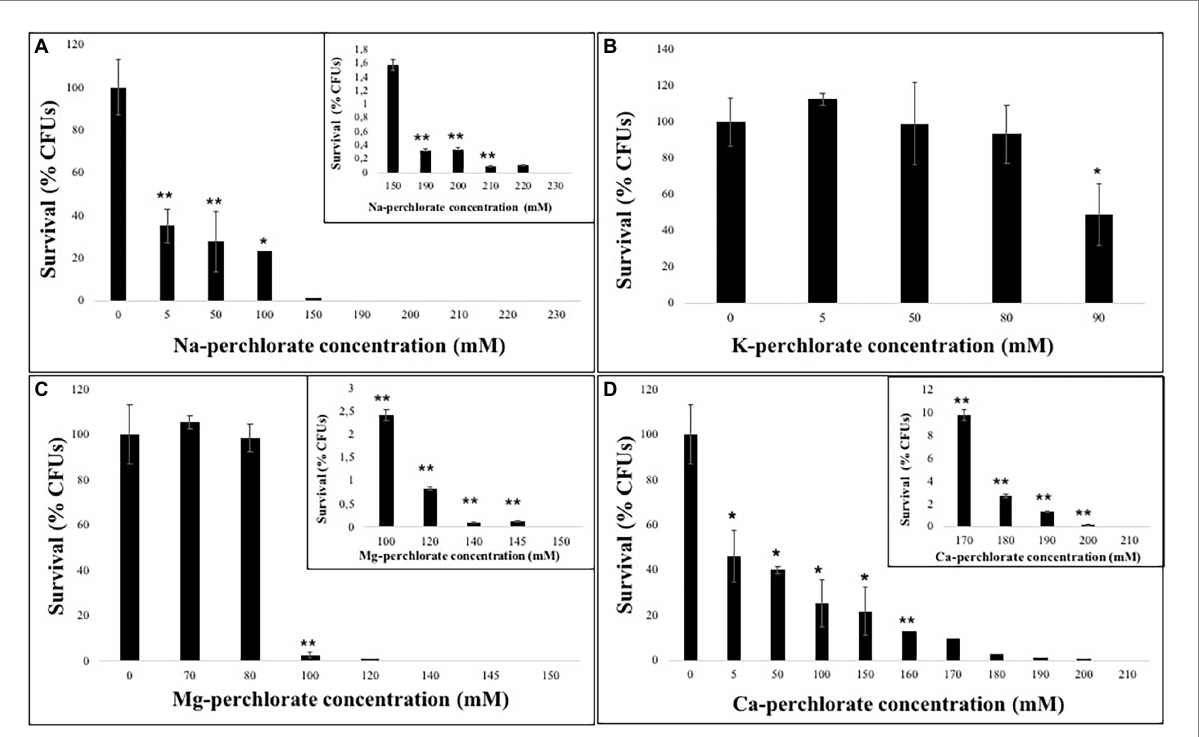
FIGURE 1 Survival ability of C. antarcticus colonies after growth on different perchlorates concentrations. (A) Na-, (B) K-, (C) Mg-, and (D) Ca-perchlorates. All concentrations are expressed in mM. Significant differences were calculated by t test with * = p < 0.05 and ** = p < 0.001.